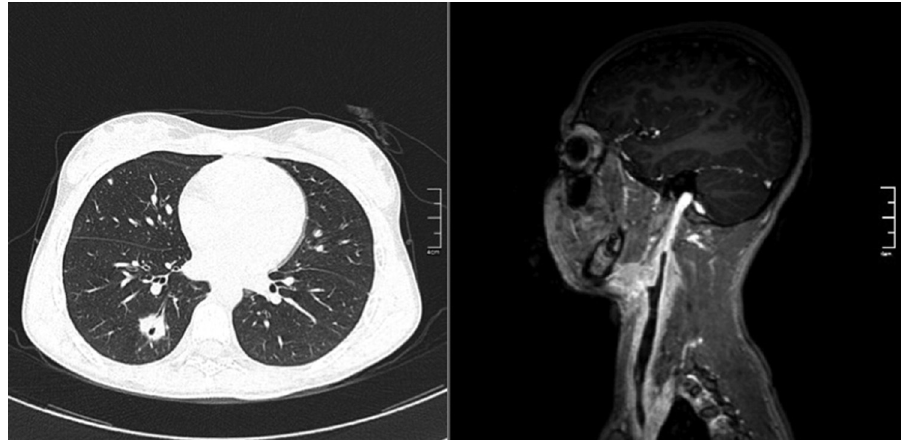
Figure 1 Left, Cross-Sectional Computed Tomography showing pulmonary microabscesses. Right, Post-contrast Sagittal T1- weighted Magnetic Ressonance Angiography, showing the Right Internal Jugular Vein filling